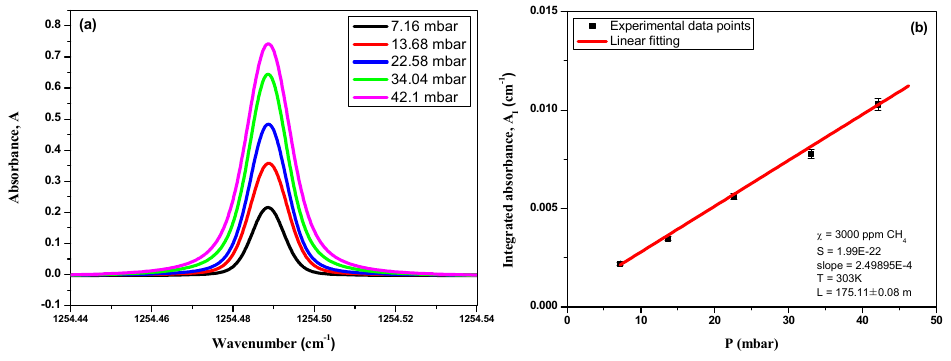
Figure 4. ( a ) 3000 ppm methane absorption spectra recorded at different pressures; ( b ) Plot of the integrated absorbance vs. pressure P , associated with a linear fit (corresponding to the A I / P ratio).